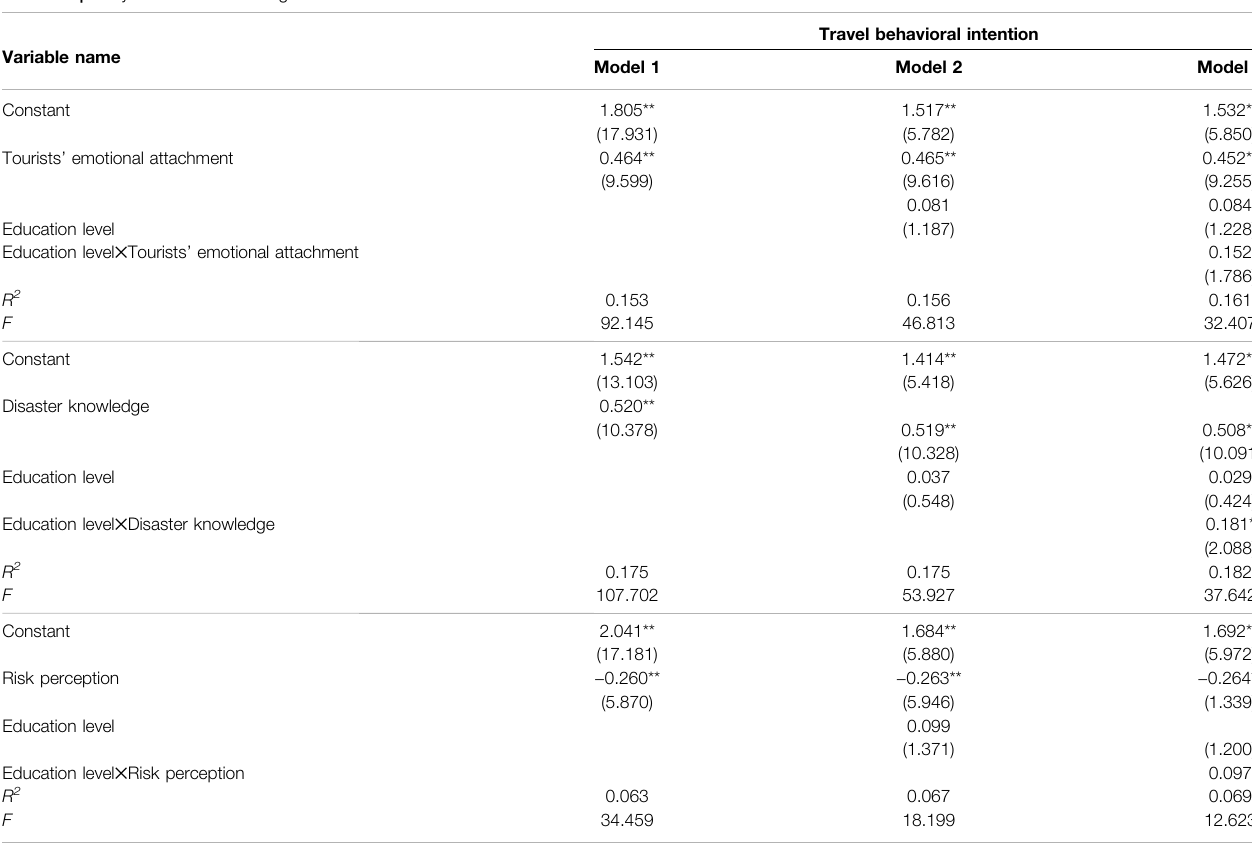
TABLE 8 | Analysis of the moderating effect of education level.